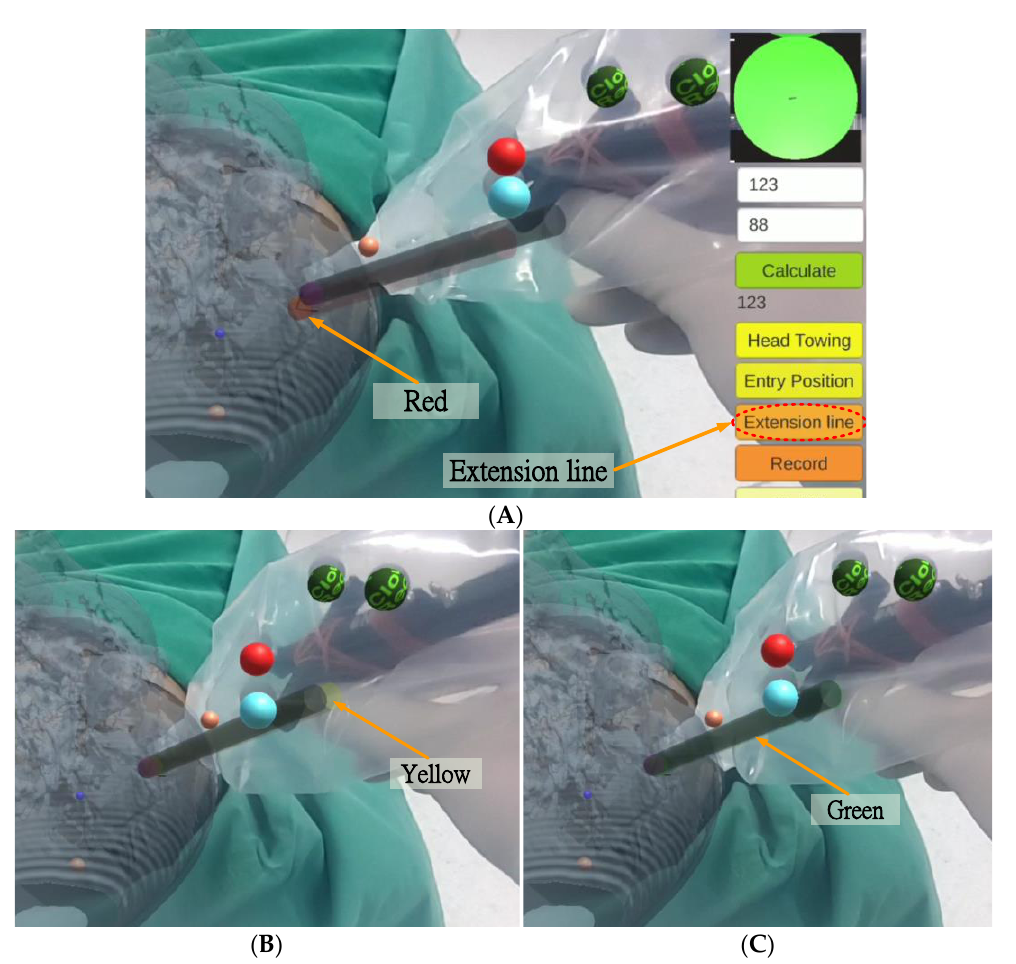
Figure 13. Extension line and three-color scalpel stick. ( A ) Extension line and red scalpel stick. ( B ) Yellow scalpel stick. ( C ) Green scalpel stick.